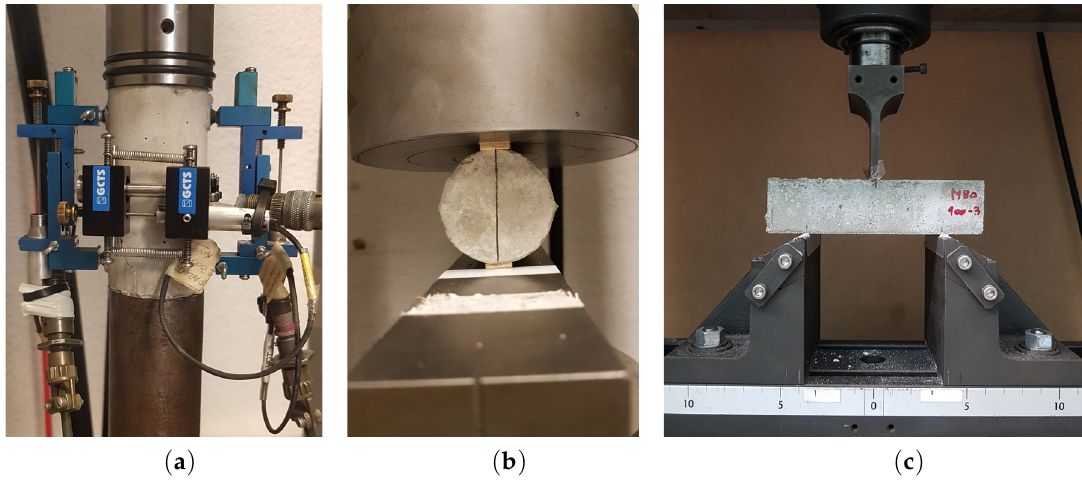
Figure 3. Experimental setups in ( a ) UC, ( b ) ST test and ( c ) F